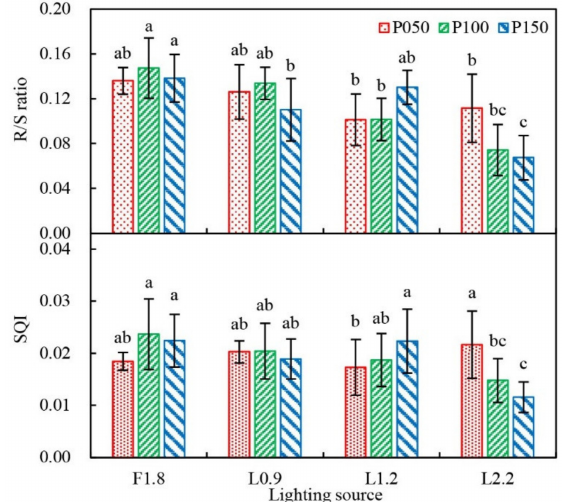
Figure 6. Root to shoot (R/S) ratio and seedling quality index (SQI) of grafted tomato transplants as affected by light quality during the whole seedling period and photon flux density in the healing stage. Means were separated by Duncan’s test at α = 0.05 level ( n = 6). Vertical bars represent standard deviations. Different letters, a–c, indicate significant